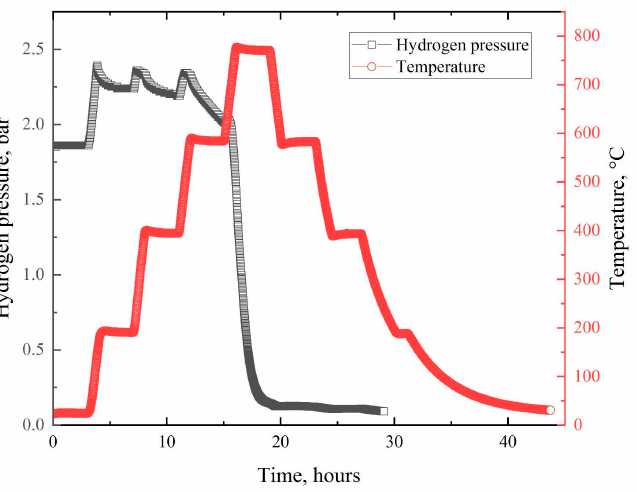
Figure 10. Temperature and hydrogen pressure profiles in dependence on time for heating of Ti samples with 64 Cu positron source in vacuum and hydrogen atmosphere.